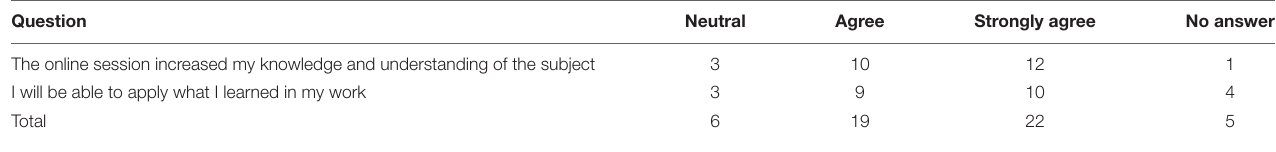
TABLE 1 | Responses to evaluation questions.